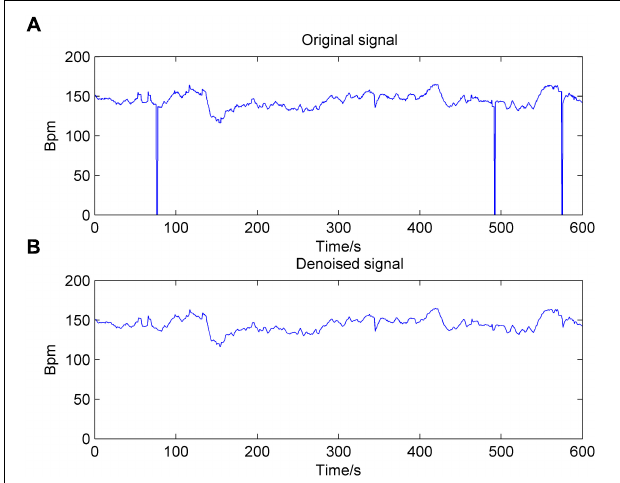
FIGURE 2 | Result of the preprocessing algorithm for the fetal heart rate (FHR) signal used in the work. (A) : original signal; (B) : denoised signal.